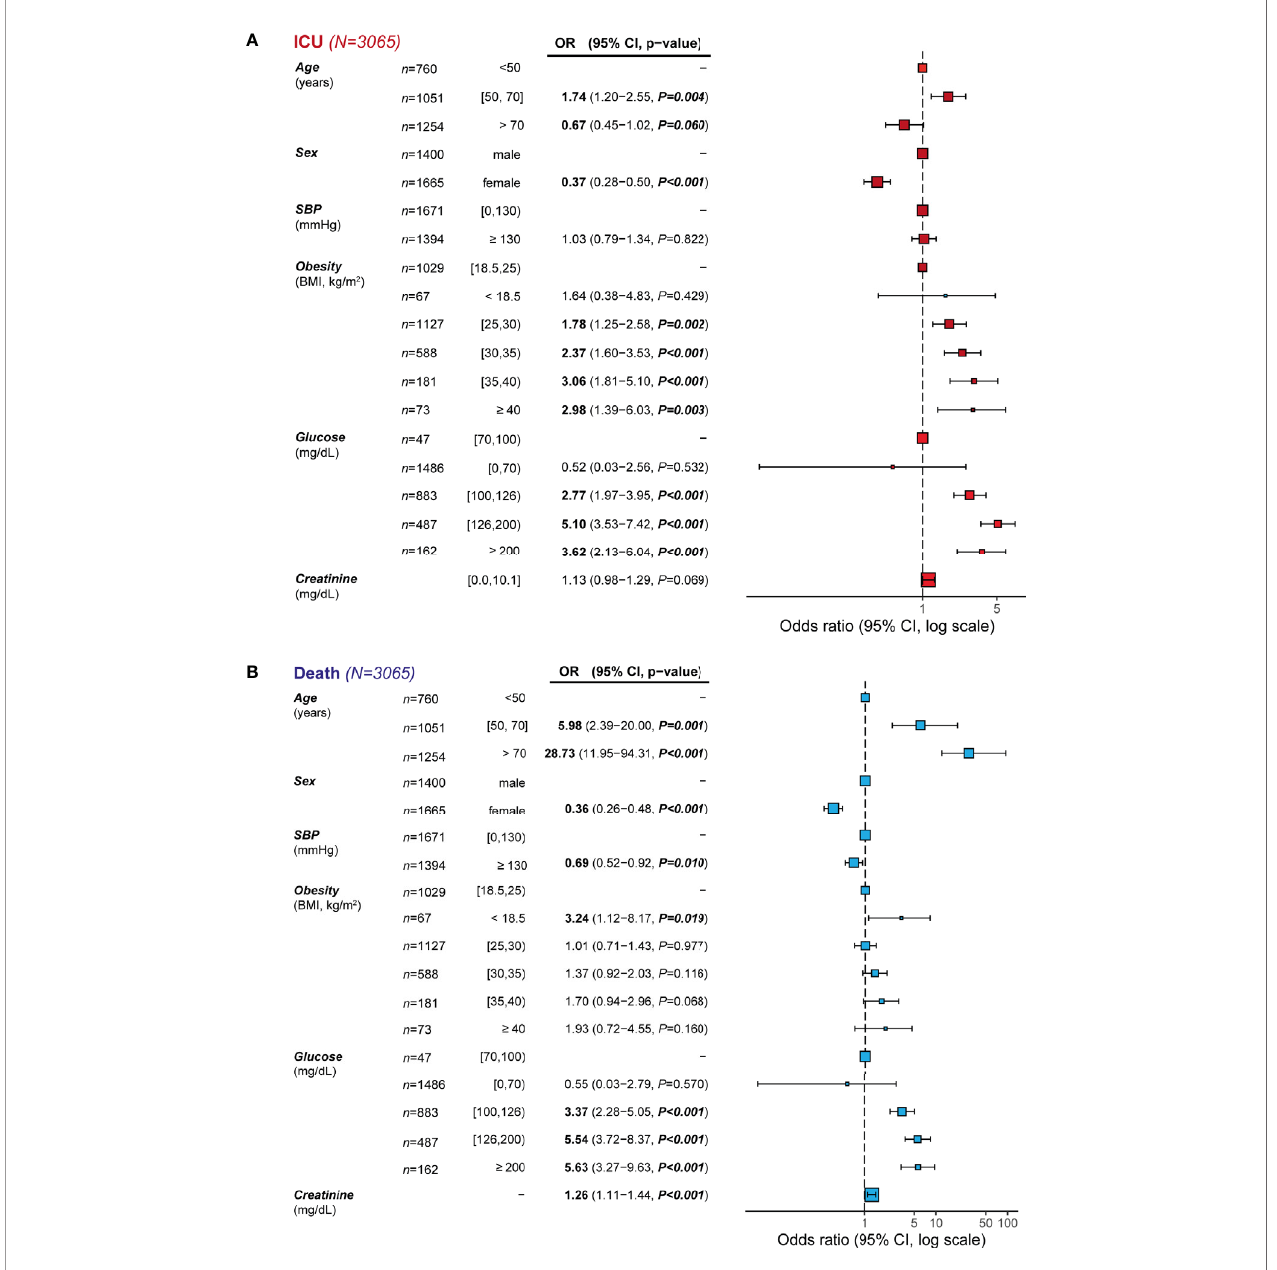
FIGURE 2 | Incidence odds ratio of (A) admission to the ICU and (B) mortality from COVID-19 by potential prognostic variables. Data are presented as odds ratio (OR) and 95% con fi dence intervals (CI). The reference groups (OR=1) for each variable are shown as “ - ” .: The odds ratios shown are adjusted through a logistic regression model which includes all variables listed. Data are also represented as a forest